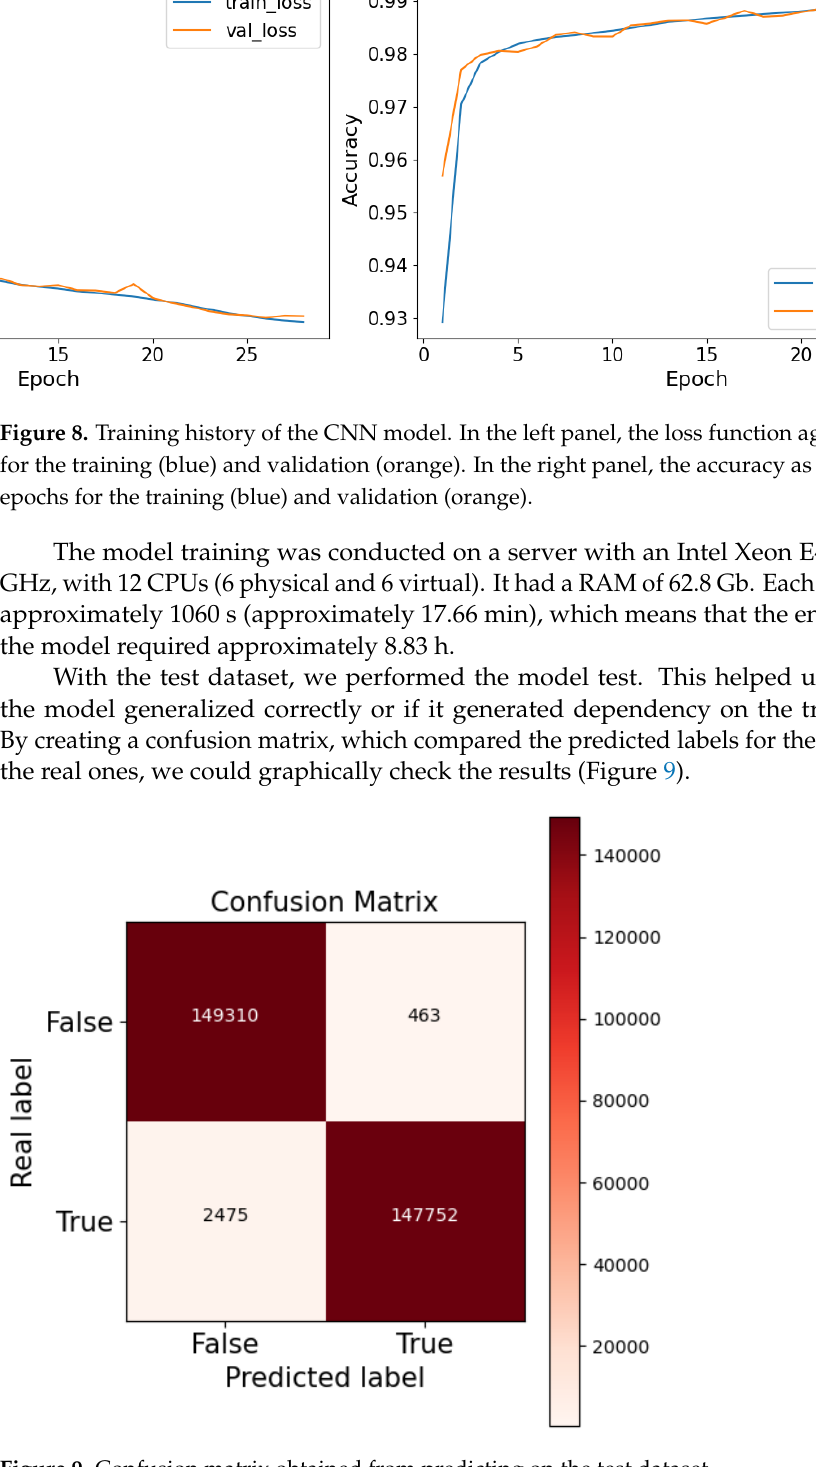
Figure 9. Confusion matrix obtained from predicting on the test